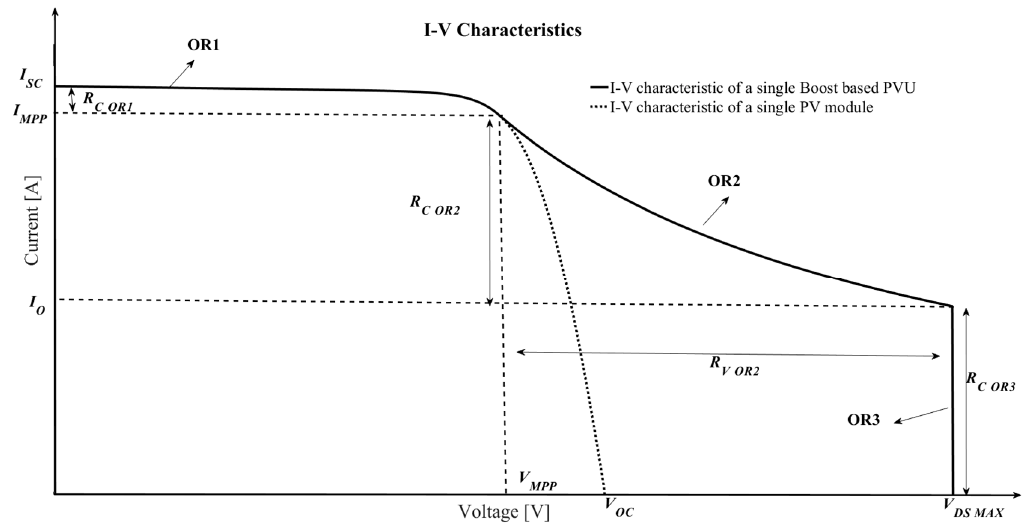
Figure 6. PV module I-V characteristic and Boost based PVU I-V characteristics.